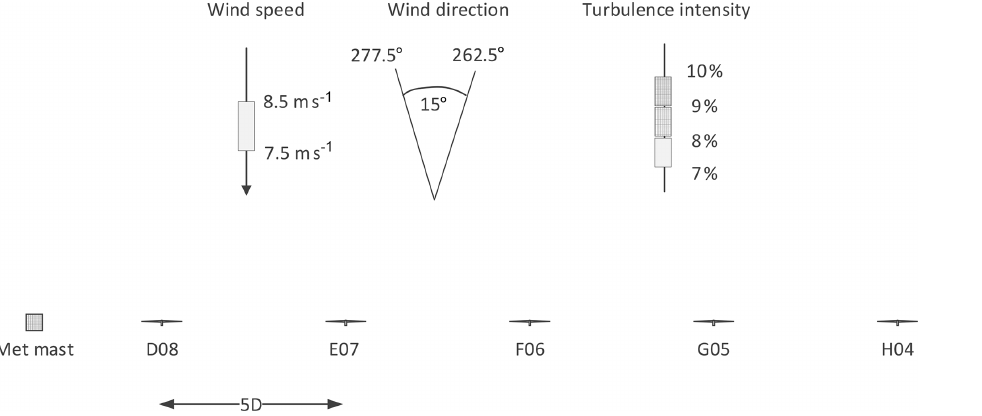
Figure 2. Top view of the westerly front row of Lillgrund wind farm and investigated range of wind conditions. Variance of second-order moment of nacelle wind speed between wind turbines is investigated with turbine no. D08 for reference.